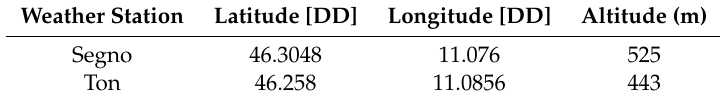
Table 2. Geographical coordinates of weather station for Example